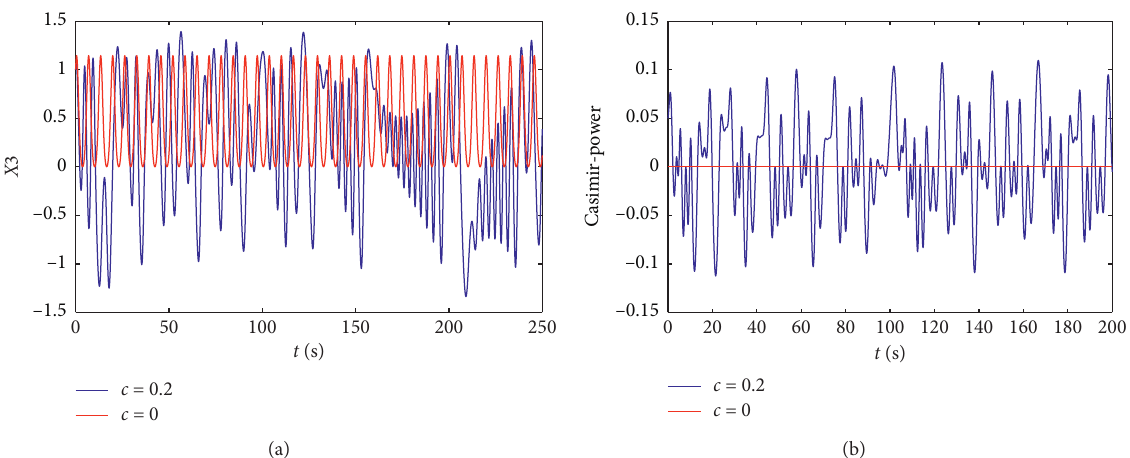
Figure 3: Time series of x . (b) Casimir powers. series of x 3